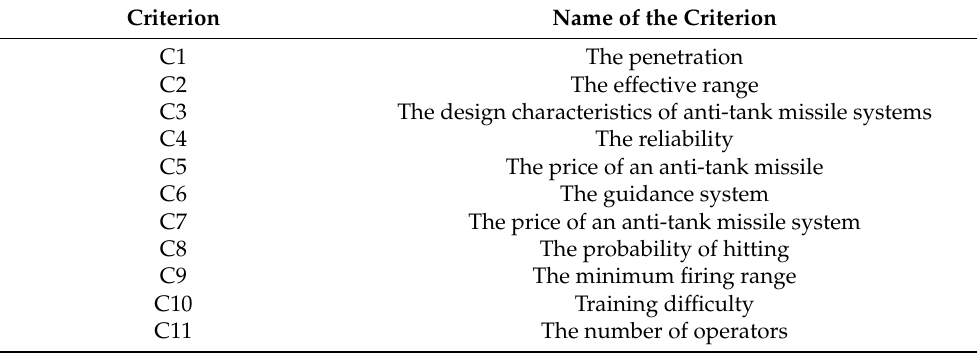
Table 4. Criteria for the selection of